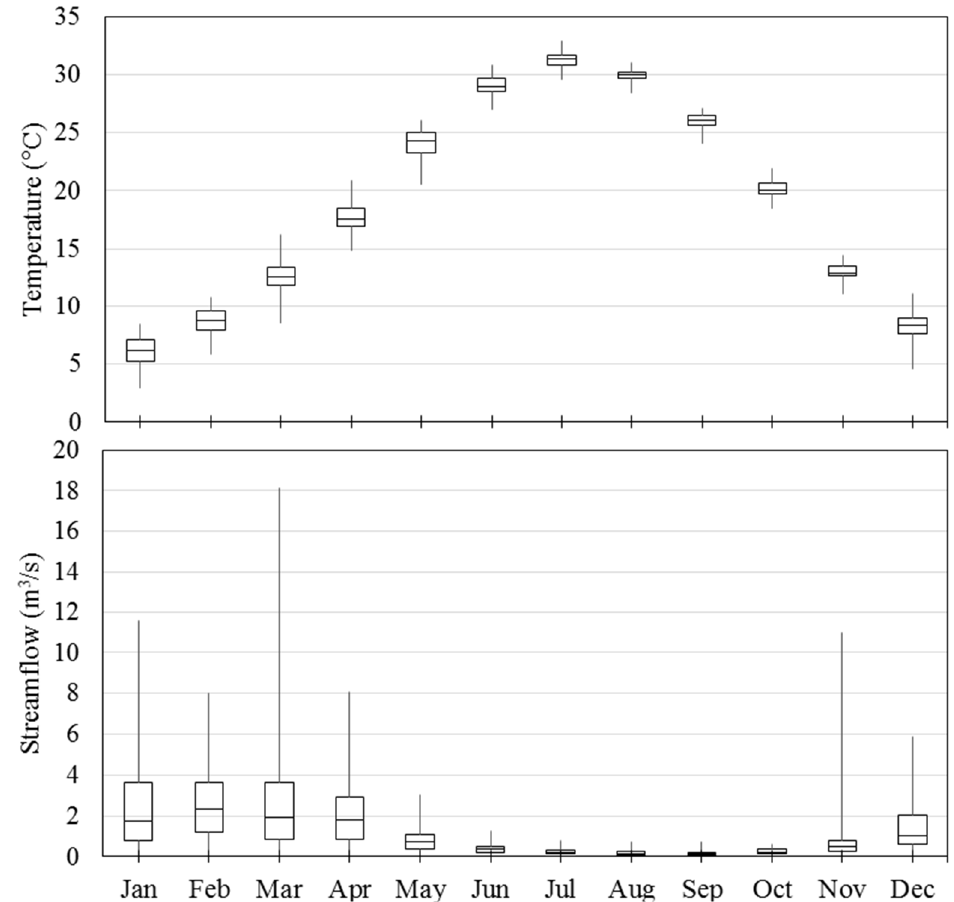
Figure 2. Average monthly variation of rainfall, temperature, and streamflow in the Maharlou Lake watershed from 1987 to 2016.